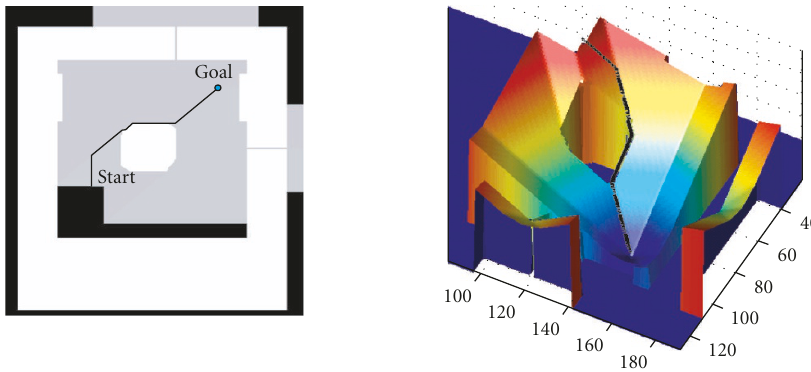
Figure 4: Environment and start/goal configuration, generated artificial potential field, and resulting path.